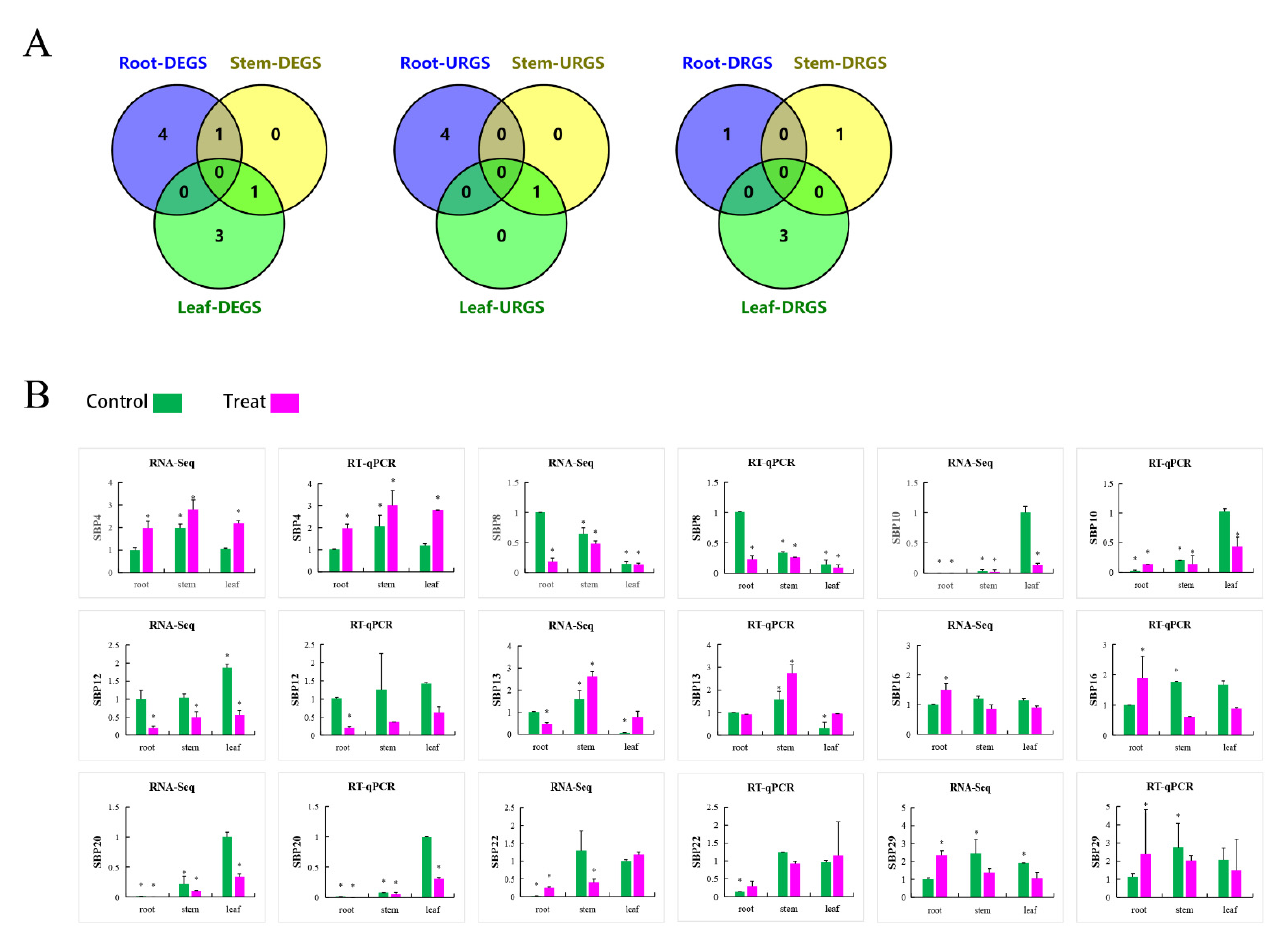
Figure 9. ( A ) Veendiagram of the DEGS expression analysis in tissues under high salt stress. The figure shows the number of DEGS under salt stress, the DEGS of upregulated, the DEGS of downregulated and the DEGS of shared in different tissues. ( B ) The expression pattern of PtSBP in different tissues under high salt stress were analyzed based on RNA-Seq and RT-qPCR. Green means control and pink means salt treatment. The relative expression level of each gene was calculated according to the corresponding gene expression level in root and leaf without treatment. Error bars represent the standard deviation of biological reproduction. “*” indicates a significant difference ( p < 0.05).